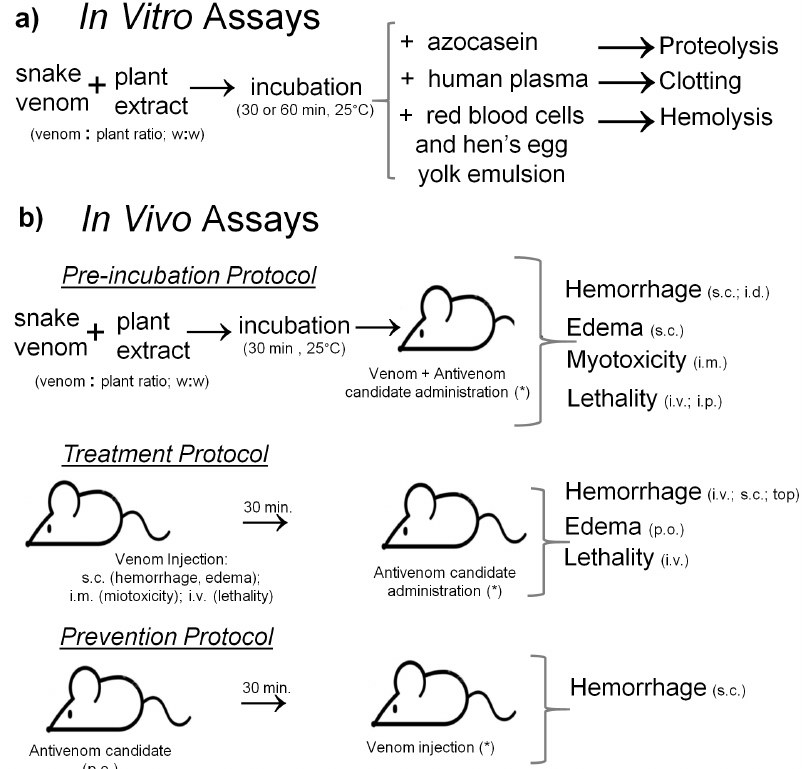
Figure 2. Antibothropic activity of Clusia fluminensis extracts assayed in vitro and in vivo . a) In vitro assays were performed in which the venoms of Bothrops jararaca or B. jararacussu were pre-incubated with plant extracts or isolated molecules and then with: (i) azocasein, (ii) plasma or (iii) a mixture of human red blood cells and hen’s egg yolk emulsion to determine, respectively (i) proteolytic inhibition, (ii) clotting time and (iii) antihemolytic activity. Hemolysis induced by the venom of B. jararacussu was not tested, since this venom has low hemolytic activity. b) In vivo antibothropic evaluation was performed using pre- incubation, treatment or prevention protocols using distinct routes of administration (*). As with the in vitro assays, in the in vivo incubation protocol, venom was pre-incubated with the plant extracts before injection in mice. For the treatment protocol, the mice were pre-injected with venom and then treated with each extract. For the prevention protocol, mice were fed with the extracts before the venom injection. Distinct routes of administration for snake venoms and plant extracts were as follows: top (topical), p.o. (oral), s.c. (subcutaneous), i.v. (intravenous), i.m. (intramuscular), i.p. (intraperitoneal), i.d. (intradermal). Positive control groups received snake venom mixed with saline, and negative controls received plant extracts alone. Myotoxicity assay was only performed for B. jararacussu envenomation, due to its marked effect compared to B. jararaca